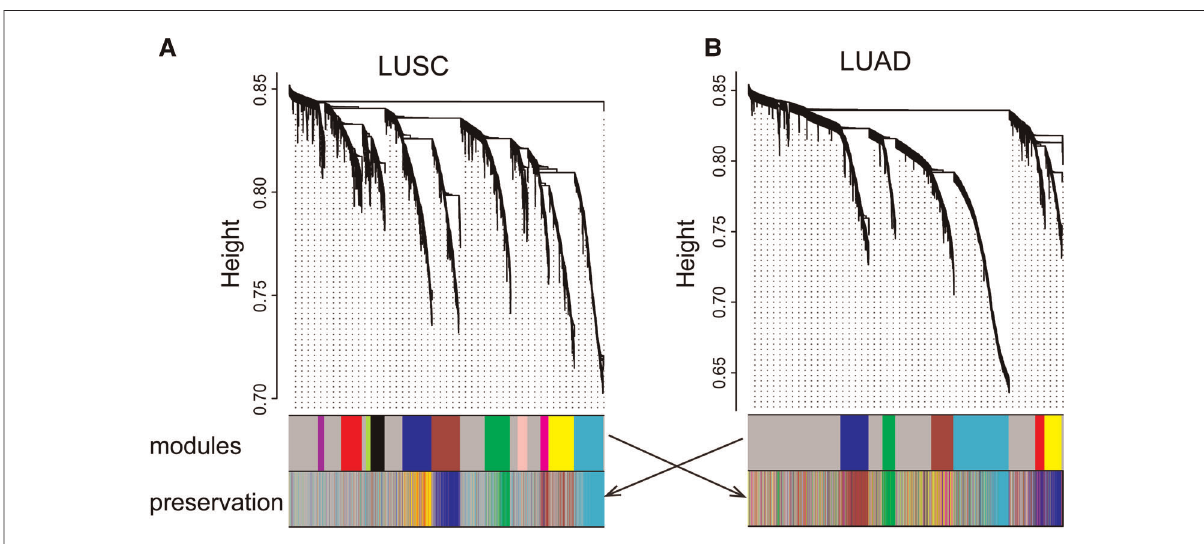
FIGURE 1 LUSC ( A ) and LUAD ( B ) networks. The upper panel shows a gene dendrogram obtained by mean linkage hierarchical clustering. The fi rst color row underneath the dendrogram shows the module assignment determined by the dynamic tree cut. The second row shows the imposition of a subtype module onto another network. These module color labels in the second row are still grouped together corresponding to the fi rst row, indicating good preservation. Note that for some modules, even with signi fi cant preservation, they cannot be seen in obvious grouping in the second dataset.